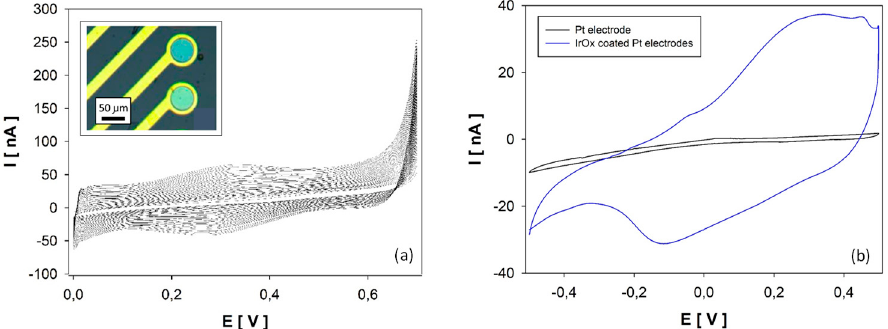
Figure 2. ( a ) Electrochemical IrOx synthesis results on a Pt 50 µm disk electrode. Inset: Image of two Pt electrodes coated with an IrOx film. ( b ) Cyclic voltamperometry results in PBS solution on a bare Pt electrode and an IrOx-coated electrode.